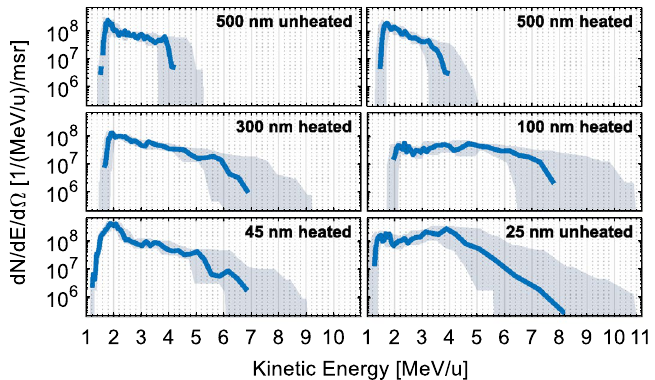
Figure 6. Gold ion energy spectra for shots on gold foils with varying thickness, integrated over all charge states. The grey error margin includes uncertainties due to the calibration of the magnetic field, the determination of the exact charge-state range and due to the intrinsic energy resolution of the TPS. Slight uncertainties of detector positioning and ion numbers have been included as well.